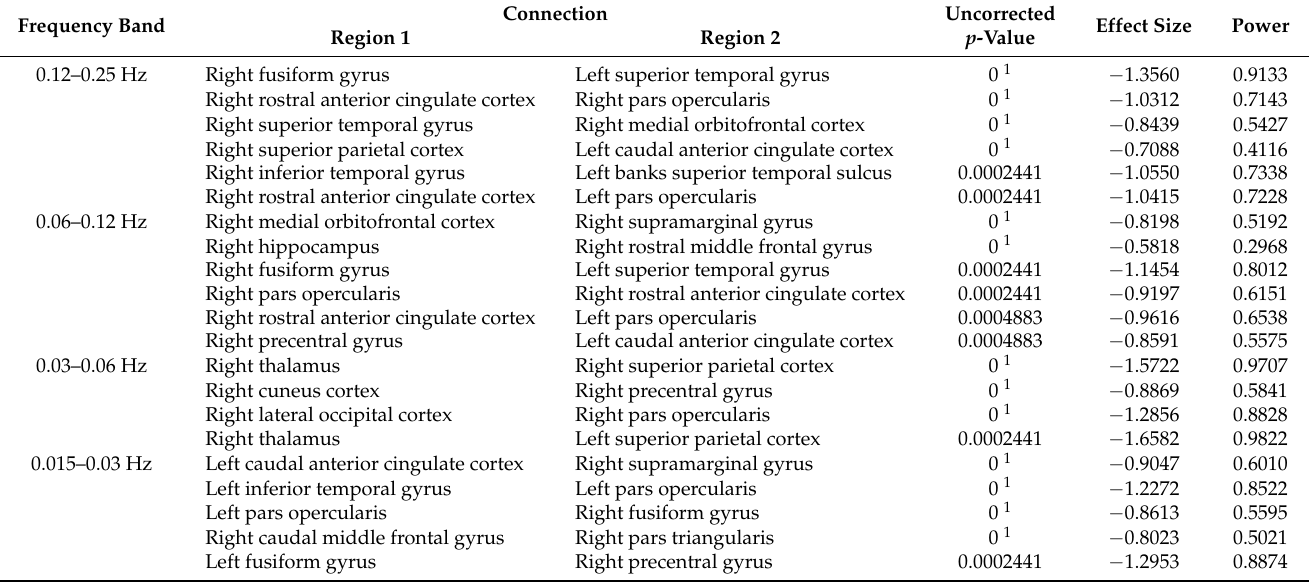
Table 6. Functional connections having connectivity change with p -value less than